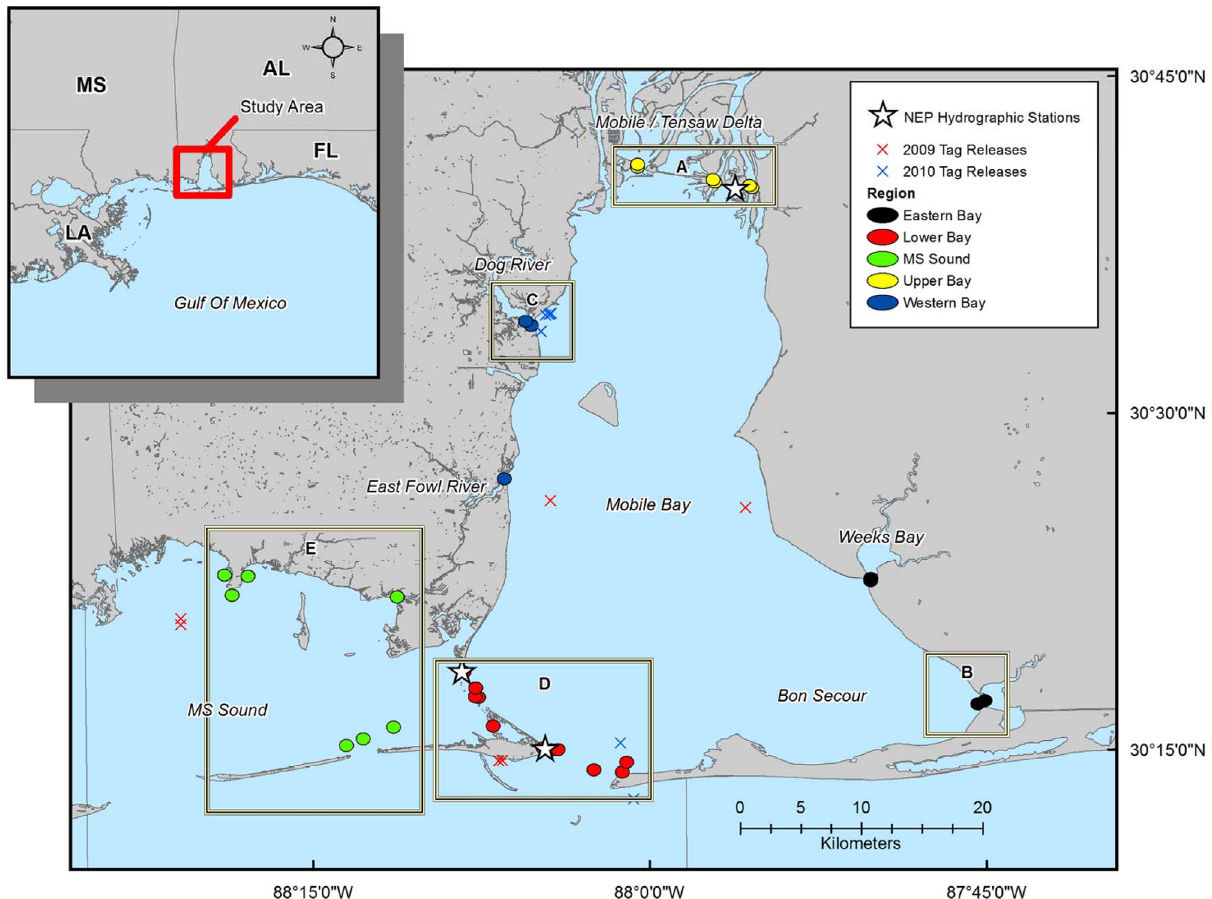
Figure 1. Map of the Coastal Alabama Acoustic Monitoring Program (CAAMP). The circles indicating receiver locations are scaled to the approximate mean detection range, and are coded by region: Upper Bay in yellow (A, n=6), Eastern Bay in black (B, n=4), Western Bay in blue (C, n=5), Lower Bay in red (D, n=11), and MS Sound in green (E, n=7). The white stars indicate the location of the National Estuary Program (NEP) mooring stations from which hydrographic data were obtained. X’s indicate release locations for the telemetered bull sharks in 2009 (red) and 2010 (blue) subsequently detected in the array.